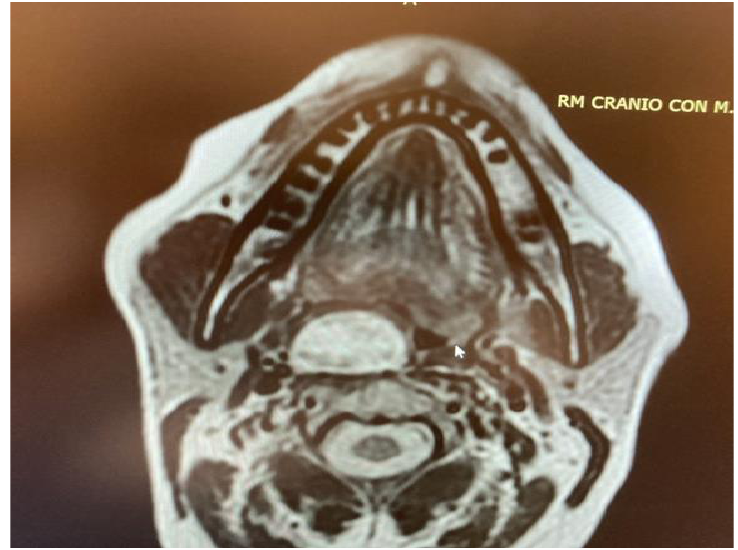
Figure 5. MRI T2 weighted image showing a right parapharyngeal schwannoma arising from the cervical sympathetic chain. The schwannoma does not dislocate the big vessels in the typical anterior direction, but the big vessels’ dislocation is posterolateral. However, the parapharyngeal fat pad is dislocated in an anterior direction, and this suggests a carotid space tumour.